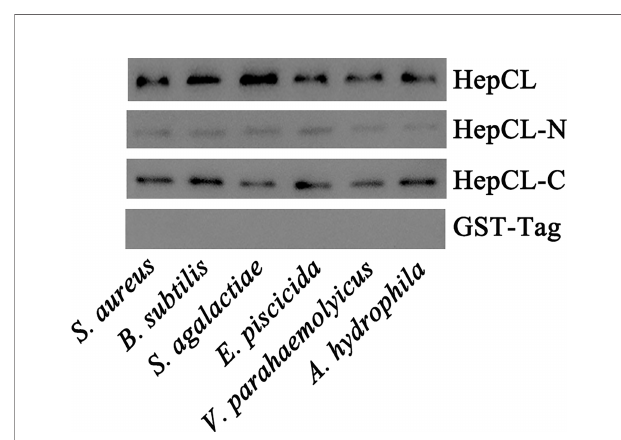
FIGURE 5 | Bacterial binding assay. Six kinds of bacteria S. aureus, B subtilis and S. agalactiae, E piscicida, V. parahaemolyticus and A hydrophila , were used to analyze the binding activity of recombinant HepCL, HepCL-N, HepCL-C by western blot, and detected with anti-GST-Tag antibody. GST- Tag was involved as